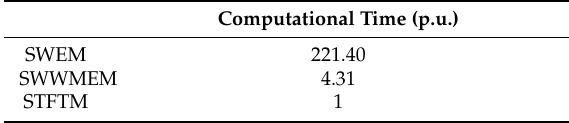
Table 2. Case study 1: computational times in per unit of computational time required by STFTM.